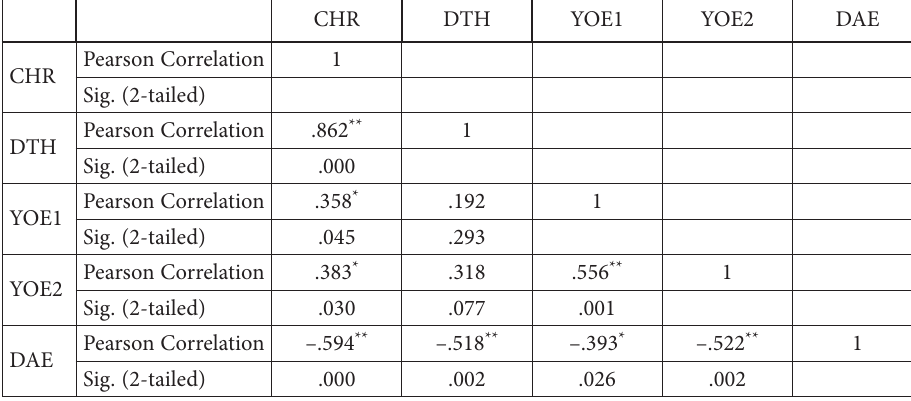
Table 6. Values of the bilateral correlations between the factorial variables in Cluster A CHR DTH YOE1 YOE2 DAE CHR